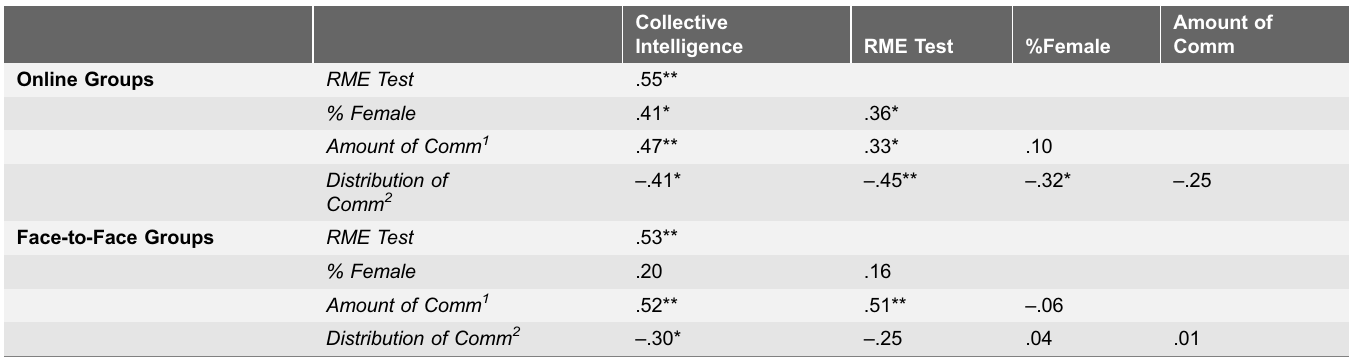
Table 1. Correlations between collective intelligence of a group and other group